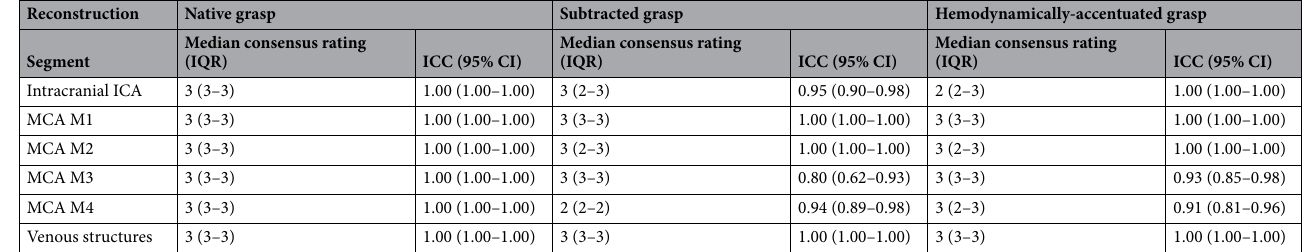
Table 2. Vascular segment rating and intraclass correlation between raters. ICC intraclass correlation coefficient, CI confidence interval, IQR interquartile range, ICA internal carotid artery, MCA middle cerebral